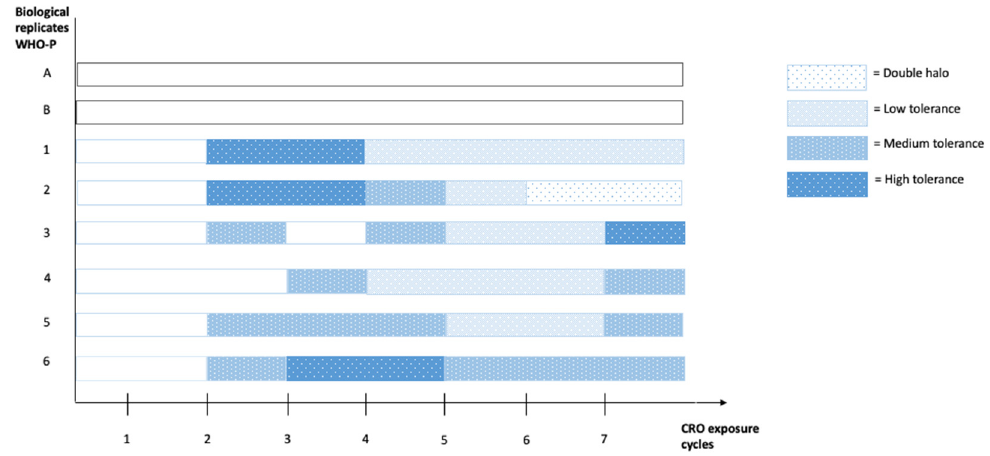
Figure 3. Evolution of the appearance of tolerance to CRO in WHO P reference N. gonorrhoeae strain (n = 6) after 3 h 10× MIC cyclic exposure to CRO, ascertained using a TD test. Samples A and B were control samples not exposed to CRO.